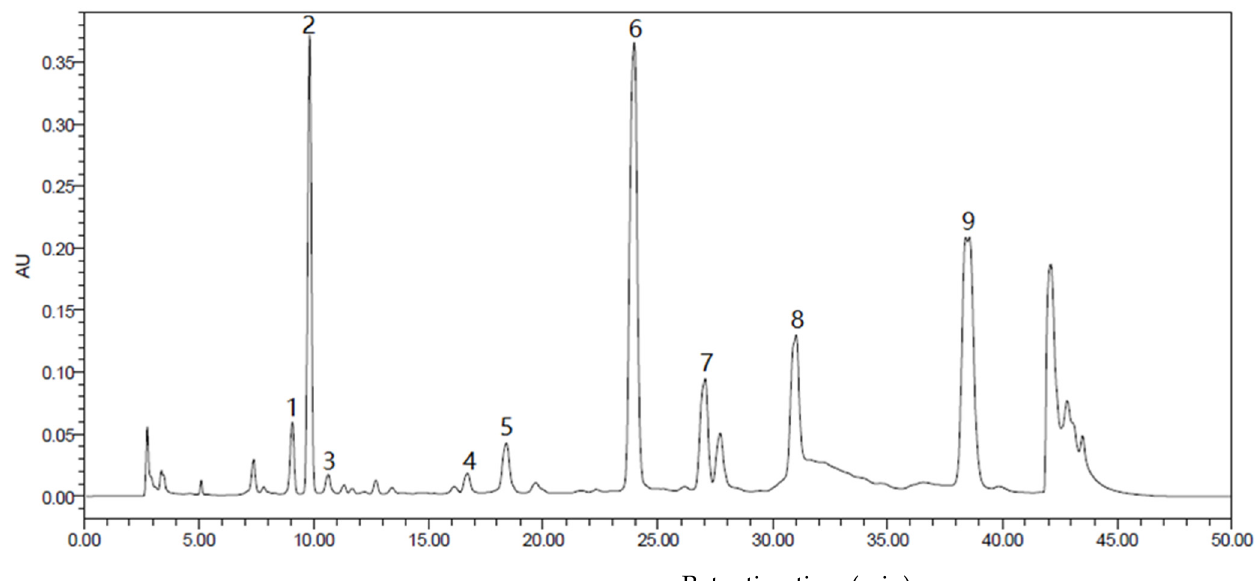
Figure 6. HPLC chromatogram of glucosinolates. 1: progoitrin (PRO); 2: glucoraphanin (GRA); 3: sinigrin (SIN); 4: 4-hydroxy-glucobrassicin (4-HGBS); 5: glucobrassicanapin (GBN); 6: glucoerucin (GER); 7: glucobrassicin (GBS); 8: 4-methoxy-glucobrassicin (4-MGBS); 9: neoglucobrassicin (NGBS). Table 1. Effects of different light intensity on glucosinolates contents in broccoli microgreens. Glucosinolates Content